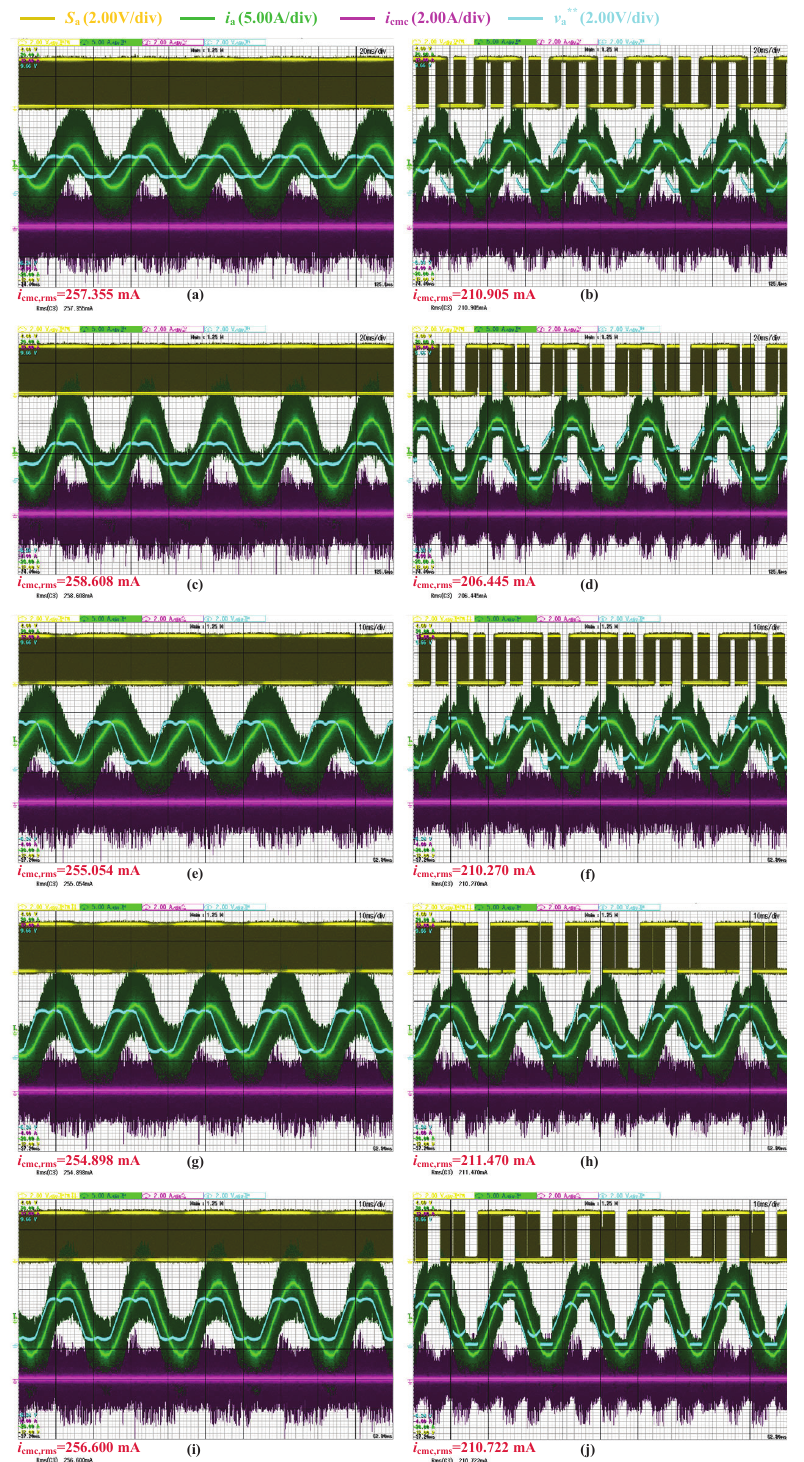
Figure 14. Output waveforms at f s = 40 kHz: ( a ) SVPWM at f o = 25 Hz and no load, ( b ) MSL-DPWM at f o = 25 Hz and no load, ( c ) SVPWM at f o = 25 Hz and half load, ( d ) MSL-DPWM at f o = 25 Hz and half load, ( e ) SVPWM at f o = 50 Hz and no load, ( f ) MSL-DPWM at f o = 50 Hz and no load, ( g ) SVPWM at f o = 50 Hz and half load, ( h ) MSL-DPWM at f o = 50 Hz and half load, ( i ) SVPWM at f o = 50 Hz and full load, and ( j ) MSL-DPWM at f o = 50 Hz and full